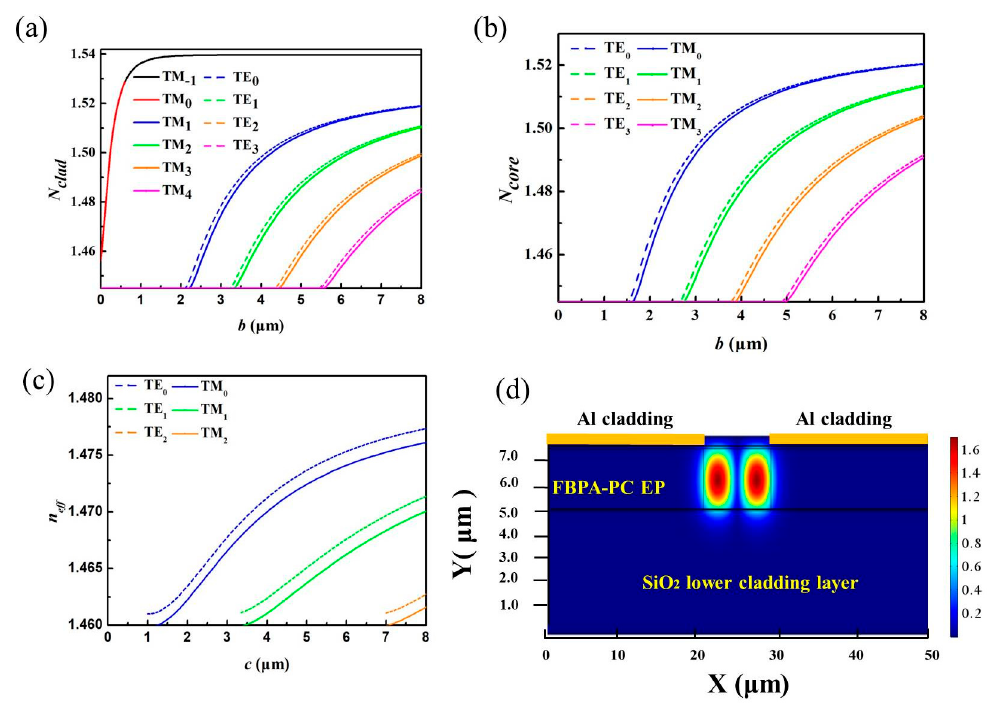
Figure 3. ( a ) Relationship between N clad and b ; ( b ) Relationship between N core and b ; ( c ) Relationship between n eff and c ; ( d ) Cross-section optical field of metal-defined waveguide structure.